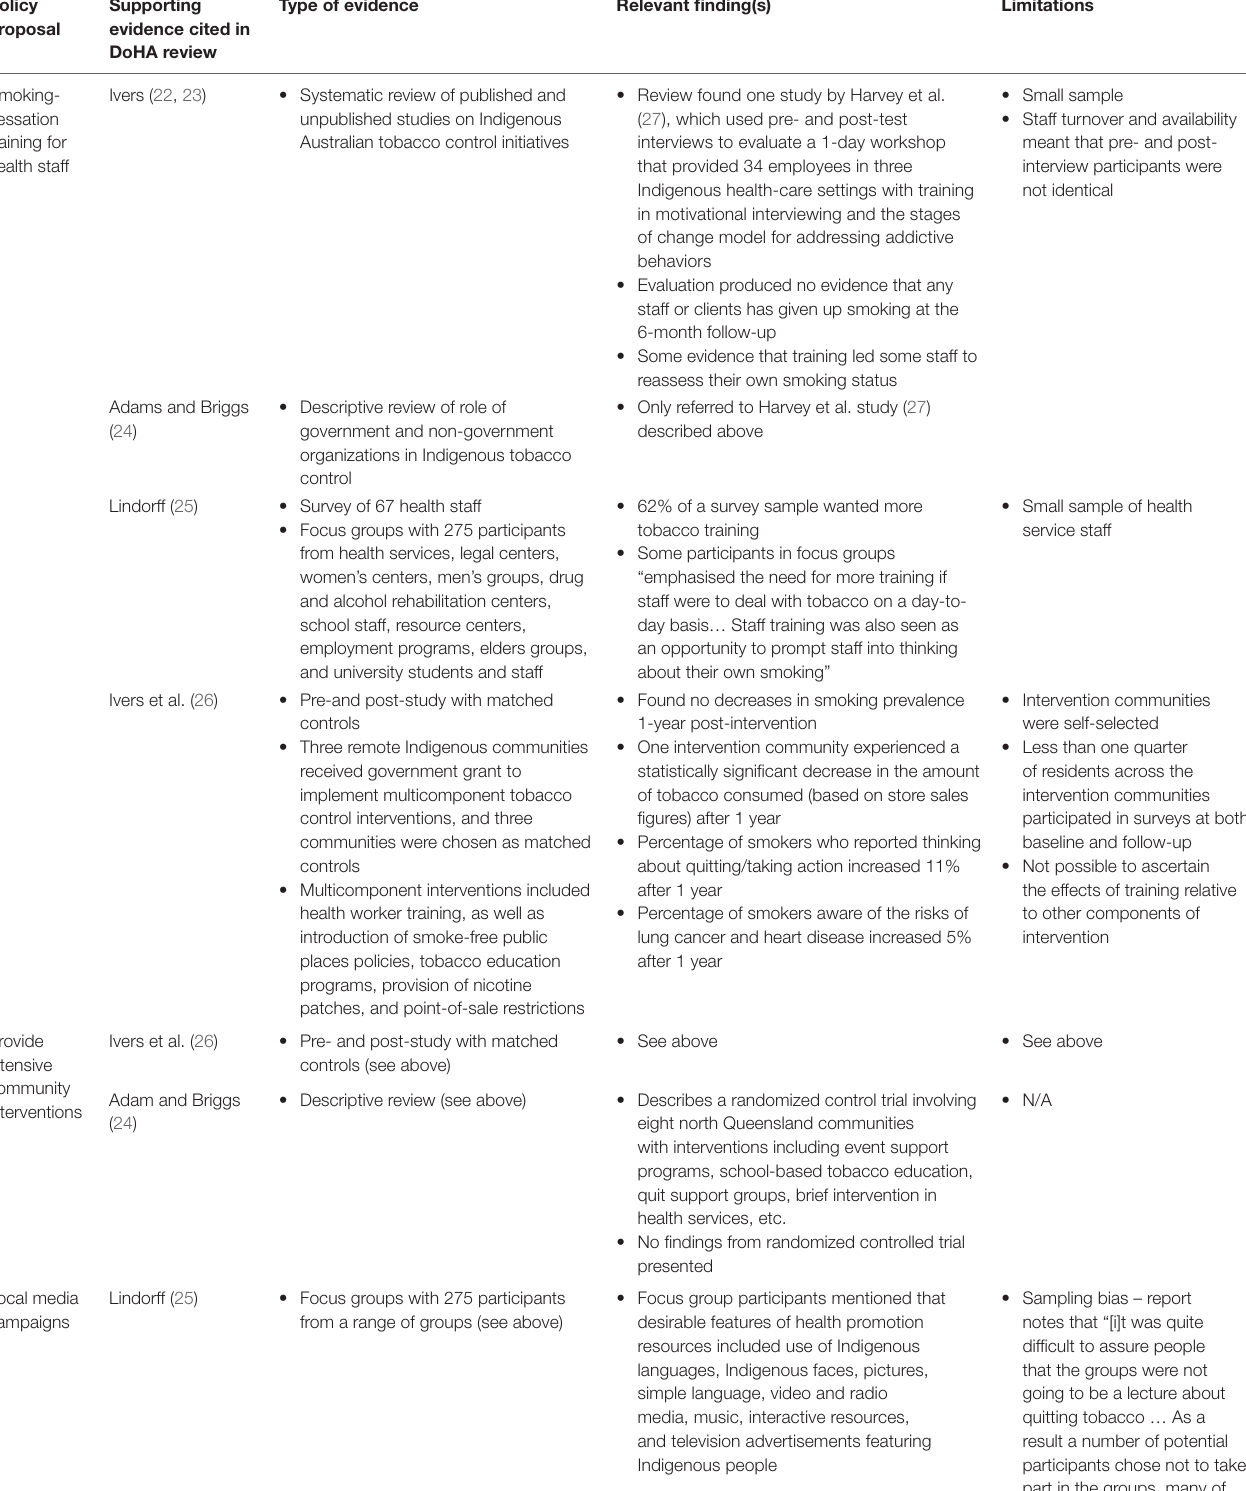
TaBle 3 | summary of studies cited in Doha (see text footnote 1) review in support of policy